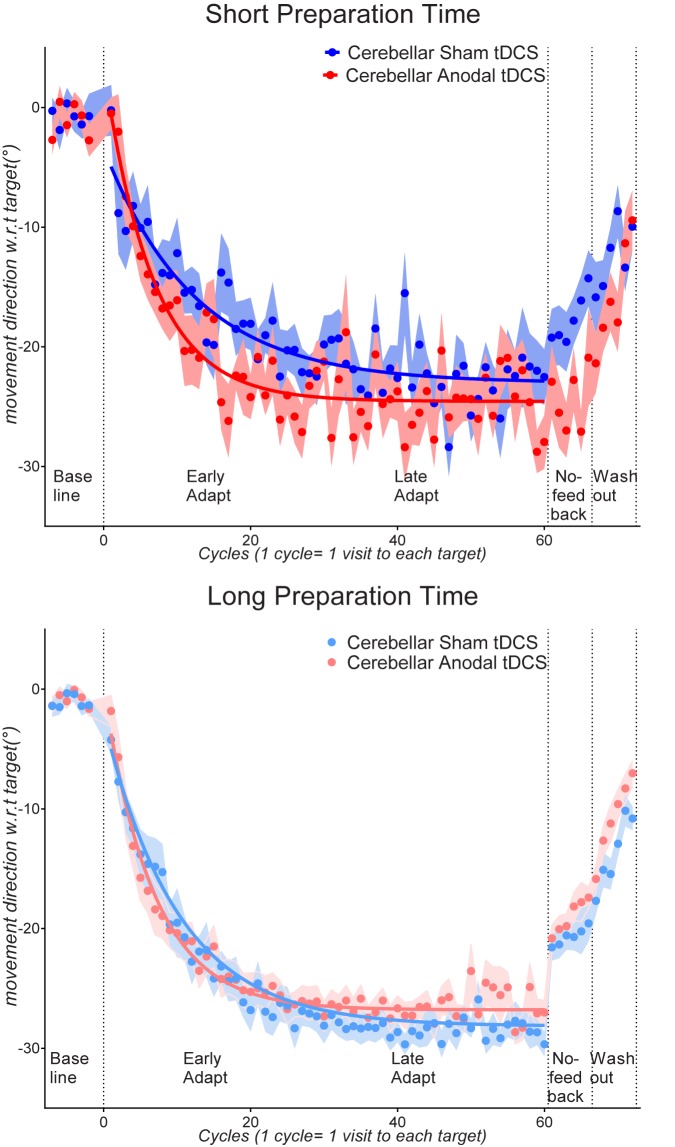
Top: Cycle by cycle movement directions with respect to the target for the short preparation time participants who received cerebellar anodal tDCS (red symbols) and cerebellar sham tDCS (blue symbols).Bottom: cycle by cycle movement directions with respect to the target for the long preparation time participants who received cerebellar anodal tDCS (pink circles) and cerebellar sham tDCS (light blue circles). Error bars indicate standard errors of the mean. Lines indicate group mean data fit to the single-rate exponential function for the adaptation phase.